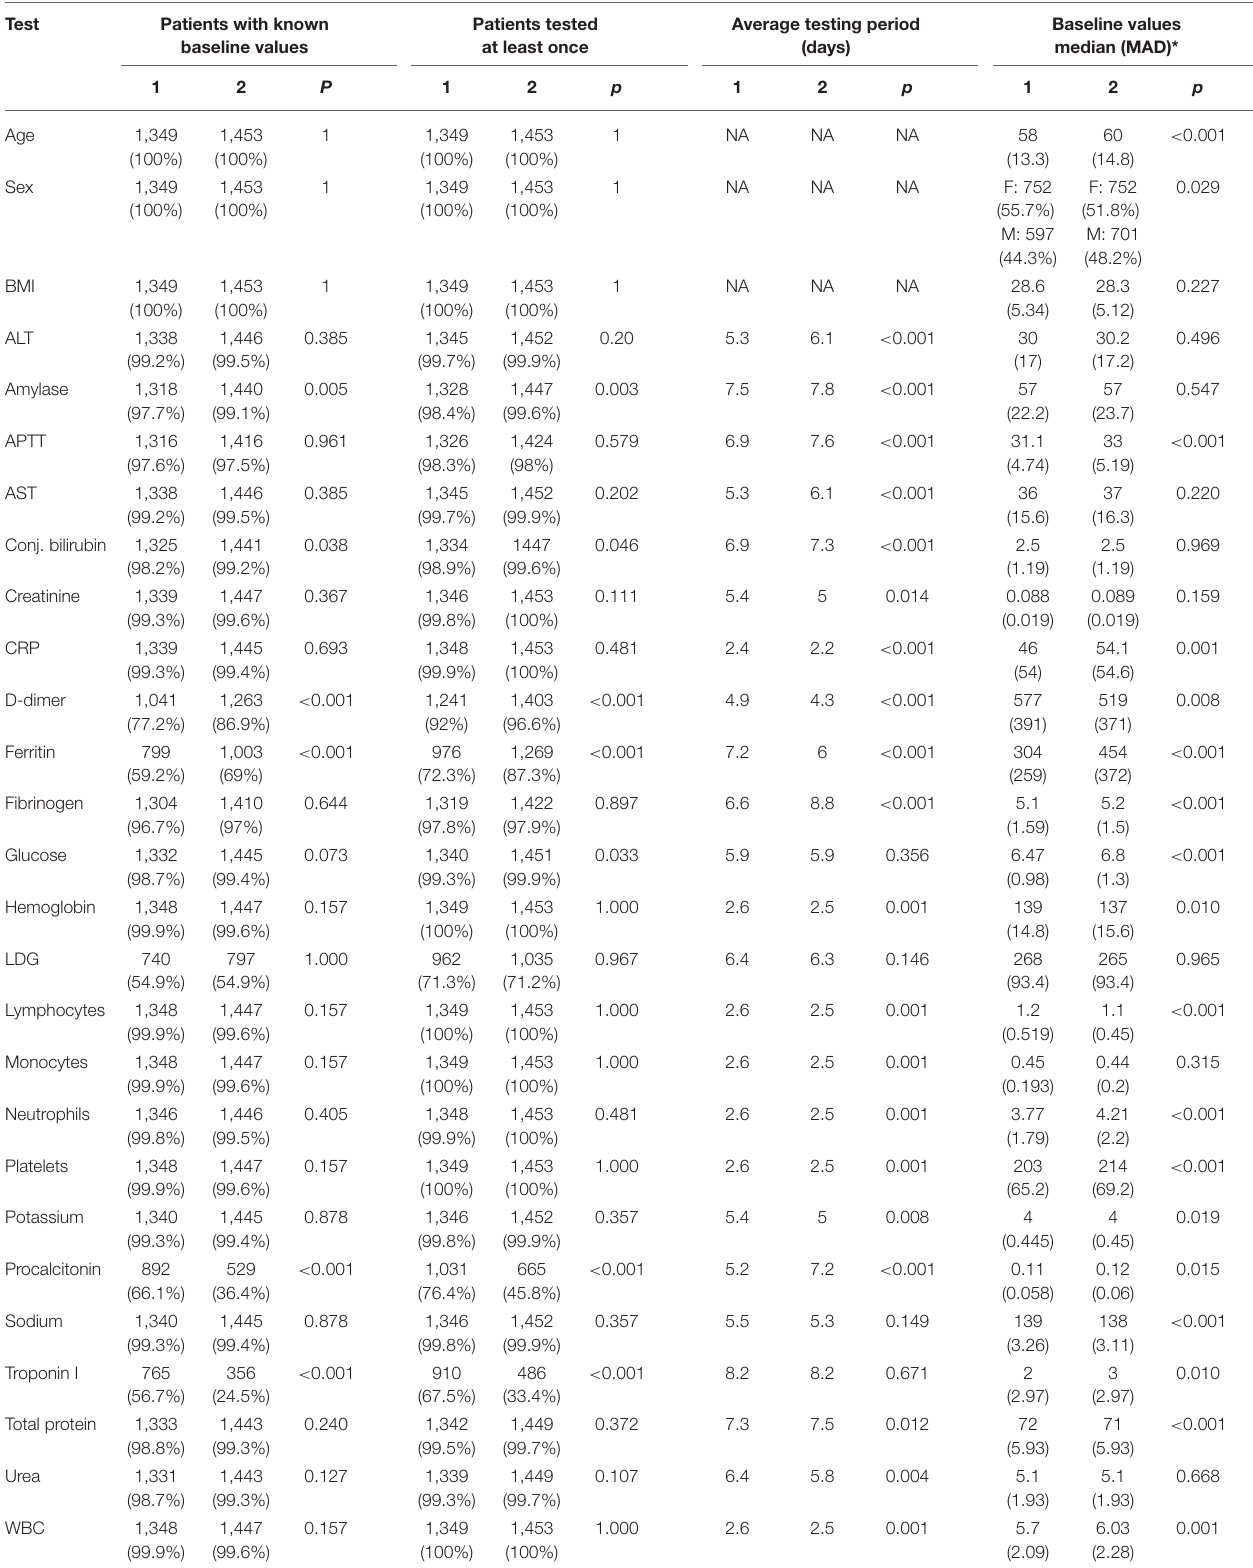
TABLE 1 | Baseline cohort characteristics.